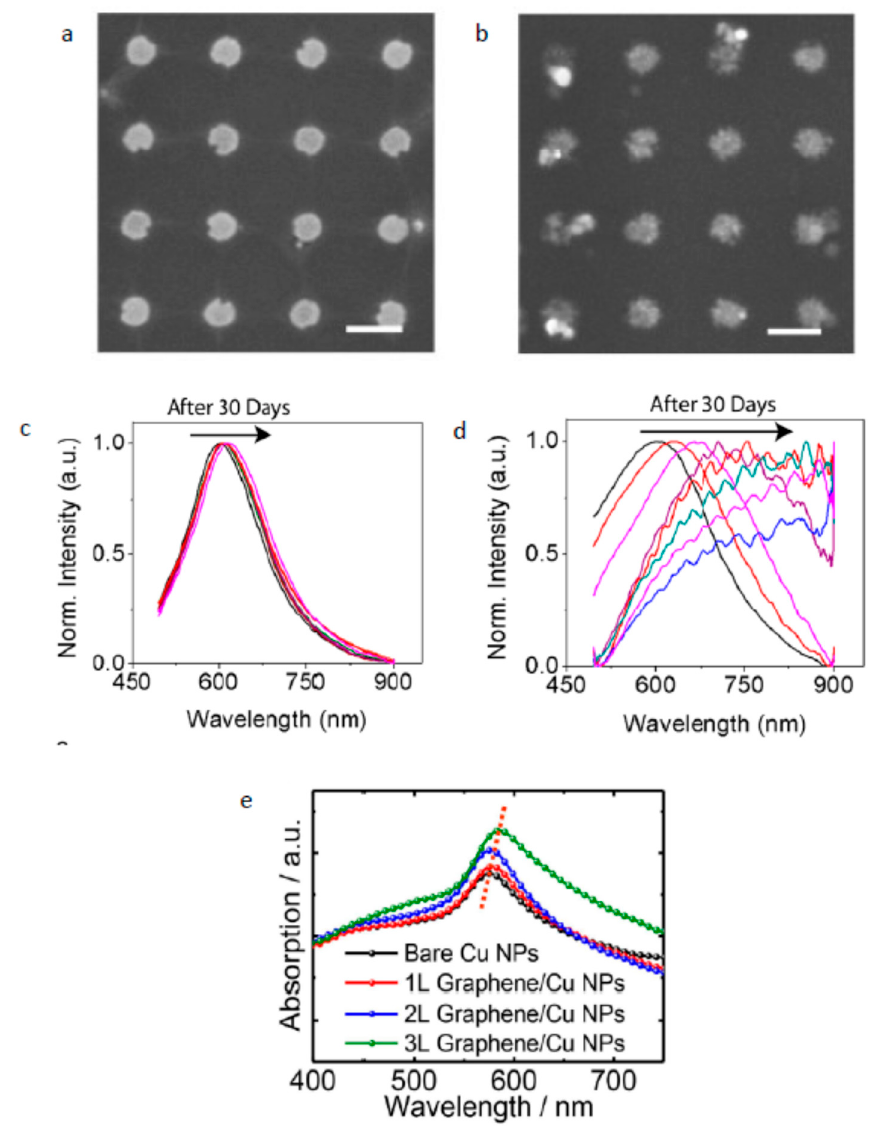
Figure 2. Scanning electron microscopy (SEM) images of a bare Ag nanoantenna ( a ) and a graphene-passivated Ag nanoantenna ( b ) after 30 days (scale bars are 200 nm), showing how graphene protects Ag NPs from degradation [60]. Bare Ag nanoantenna’s ( c ) and graphene-passivated Ag NPs’ ( d ) normalized (Norm.) reflection spectra over 30 days, which shows how the passivation of Ag with graphene enhances the stability of Ag NPs [60]. Optical absorption spectra for the Cu NPs coated with a few graphene layers [61].